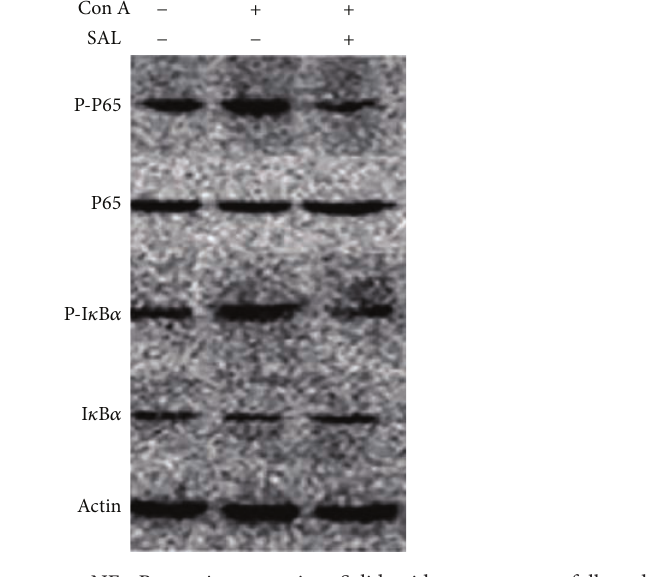
Figure 5: The effect of salidroside pretreatment on NF- 𝜅 B protein expression. Salidroside pretreatment followed Con A administration attenuated I 𝜅 B 𝛼 and p65